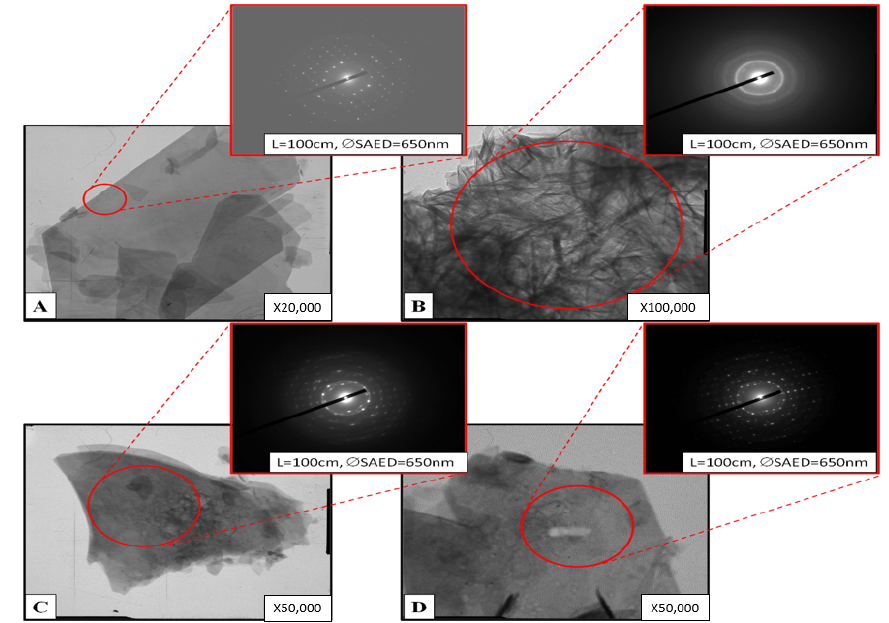
Figure 4. TEM images of characteristic samples ( A , B ) OCP and ( C , D ) OCP-Sr _10.